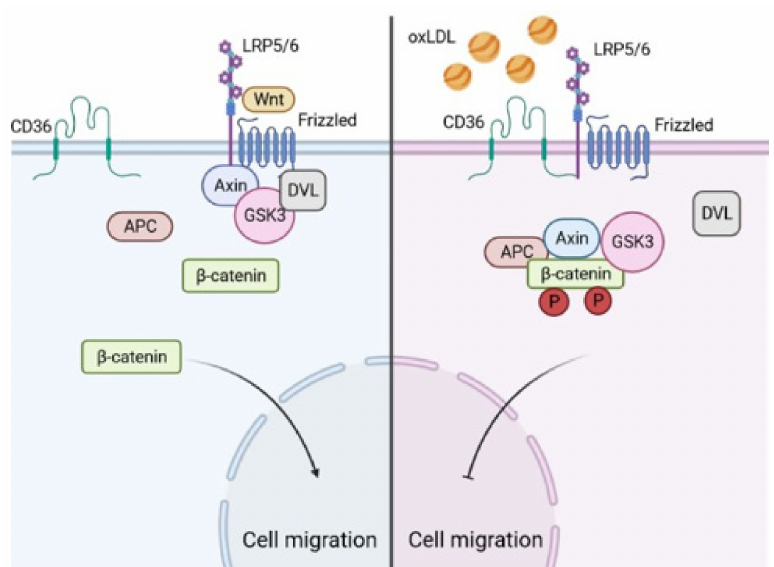
Figure 6. Schematic representation of cell migration inhibition by oxLDL. On the left: without oxLDL, Wnt ligands activate cell signaling by binding the Frizzled and LRP5/6 receptors at the cell surface, which leads to the delivery of β -catenin that induces cell migration. On the right: in the presence of oxLDL, CD36 interacts with the Frizzled and LRP5/6 receptors, bypassing Wnt, which leads to the degradation of β -catenin and results in a reduction in cell migration. Figure created using BioRender.com, accessed on 5 April